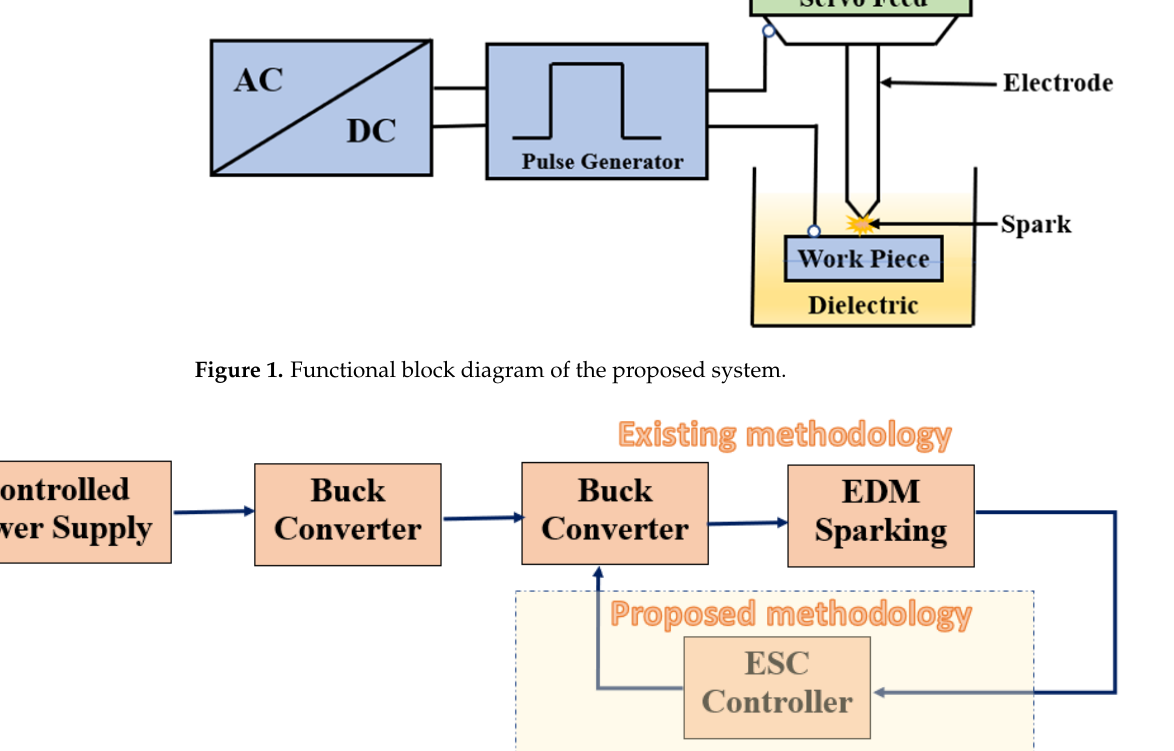
Figure 2. Proposed low-power EDM with ESC controller in feedback path.